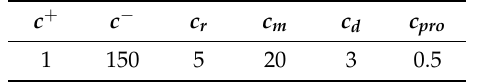
Table 2. Cost parameters for the numerical